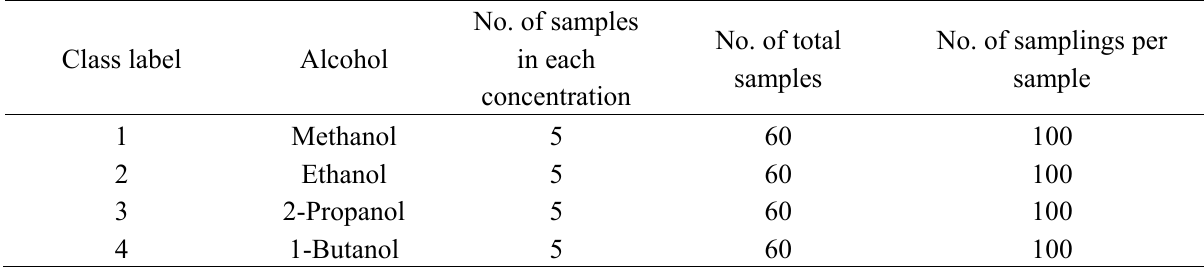
Table 1. Detail of the data sets and classes